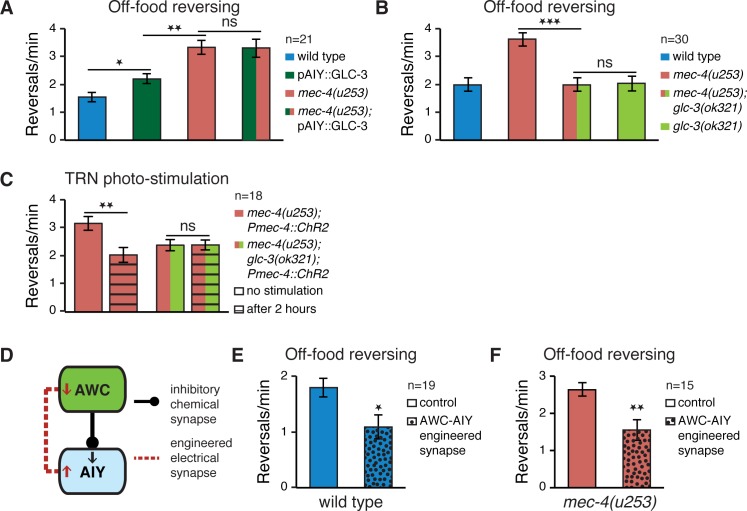
AWC→AIY transmission underlies TRN activity-dependent modulation of locomotion.(A) Overexpression of glutamate receptor GLC-3 in AIY increases off-food reversing rate, but is not additive with the effects of loss of body touch. (B) In glc-3 mutants, loss of touch responsiveness does not increase reversing rate. (C) Optogenetic TRN stimulation of glc-3; mec-4 double mutants does not alter their reversing frequency off-food compared to naïve controls (2-way ANOVA interaction p = 0.014). (D) Inserting an engineered electrical synapse between AWC and AIY attenuates AWC→AIY inhibitory transmission, since it offsets the AWC to AIY inhibitory negative signal (↓) with a positive signal (↑) and at the same time also feeds back a negative signal (↓) into AWC. (E) An engineered electrical synapse inserted between AWC and AIY reduces reversing frequency in wild type. (F) An engineered electrical synapse inserted between AWC and AIY counteracts the increased reversing rate of Mec mutants. Sample size indicated in each panel; Error bars represent SEMs; *p < 0.05, **p < 0.01, ***p < 0.001 t test with Bonferroni corrections for multiple comparisons where relevant.